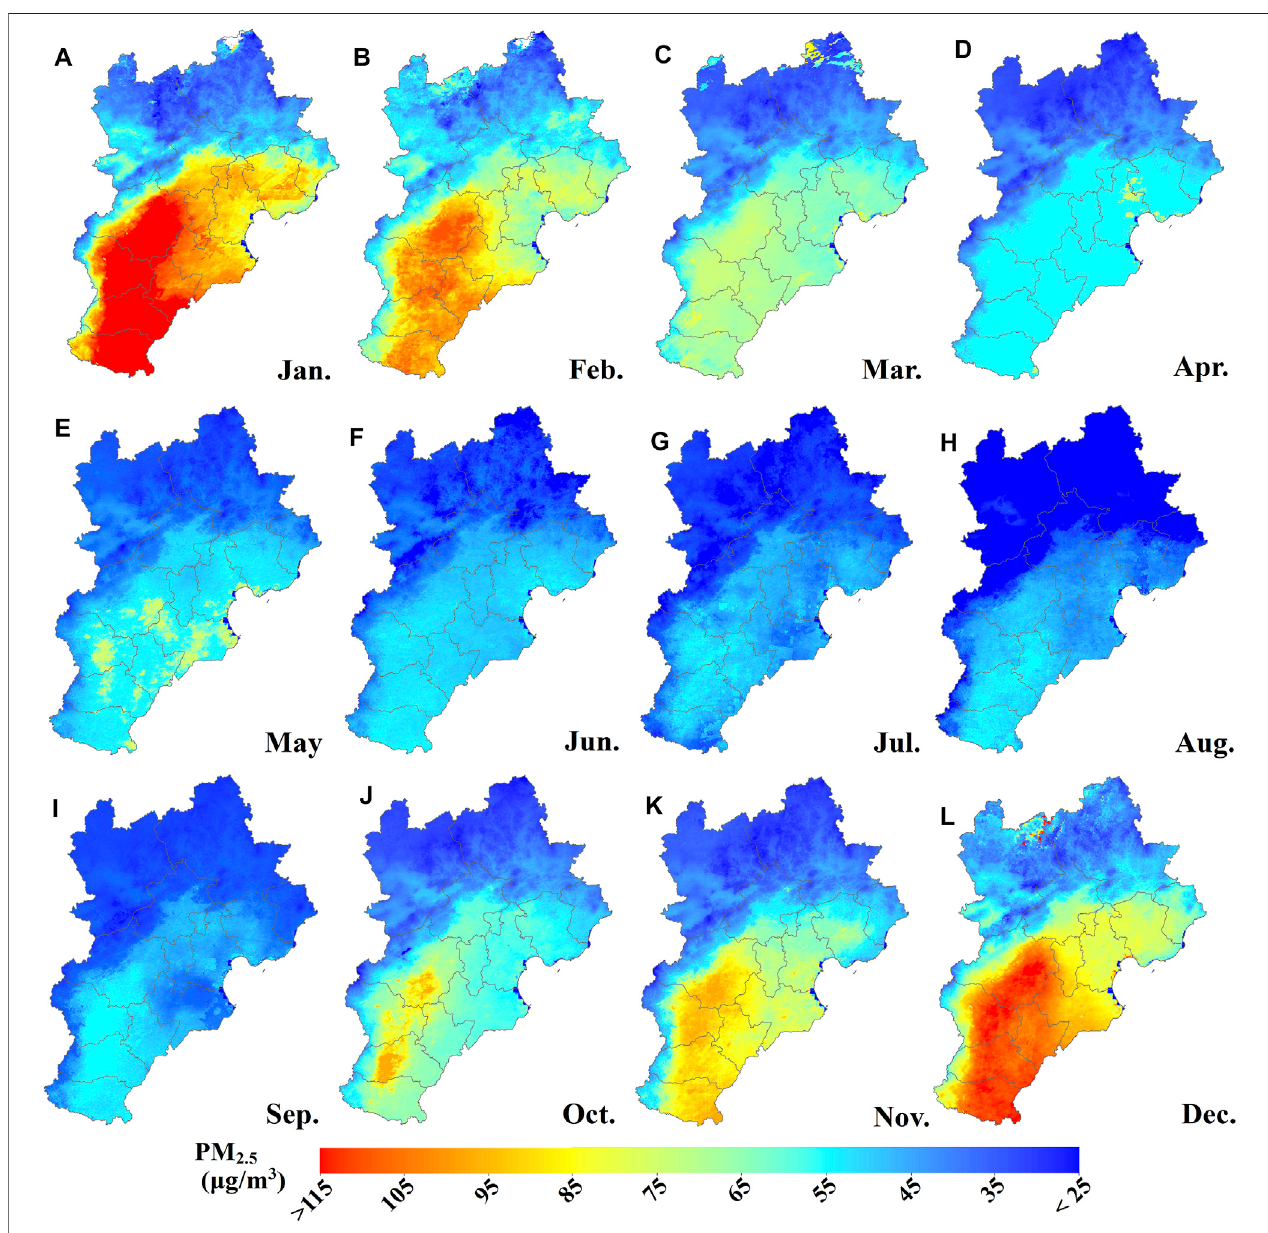
FIGURE 10 | Spatial distributions of monthly mean PM 2.5 concentrations (A – L) in the Beijing – Tianjin – Hebei region during 2013 – 2020.